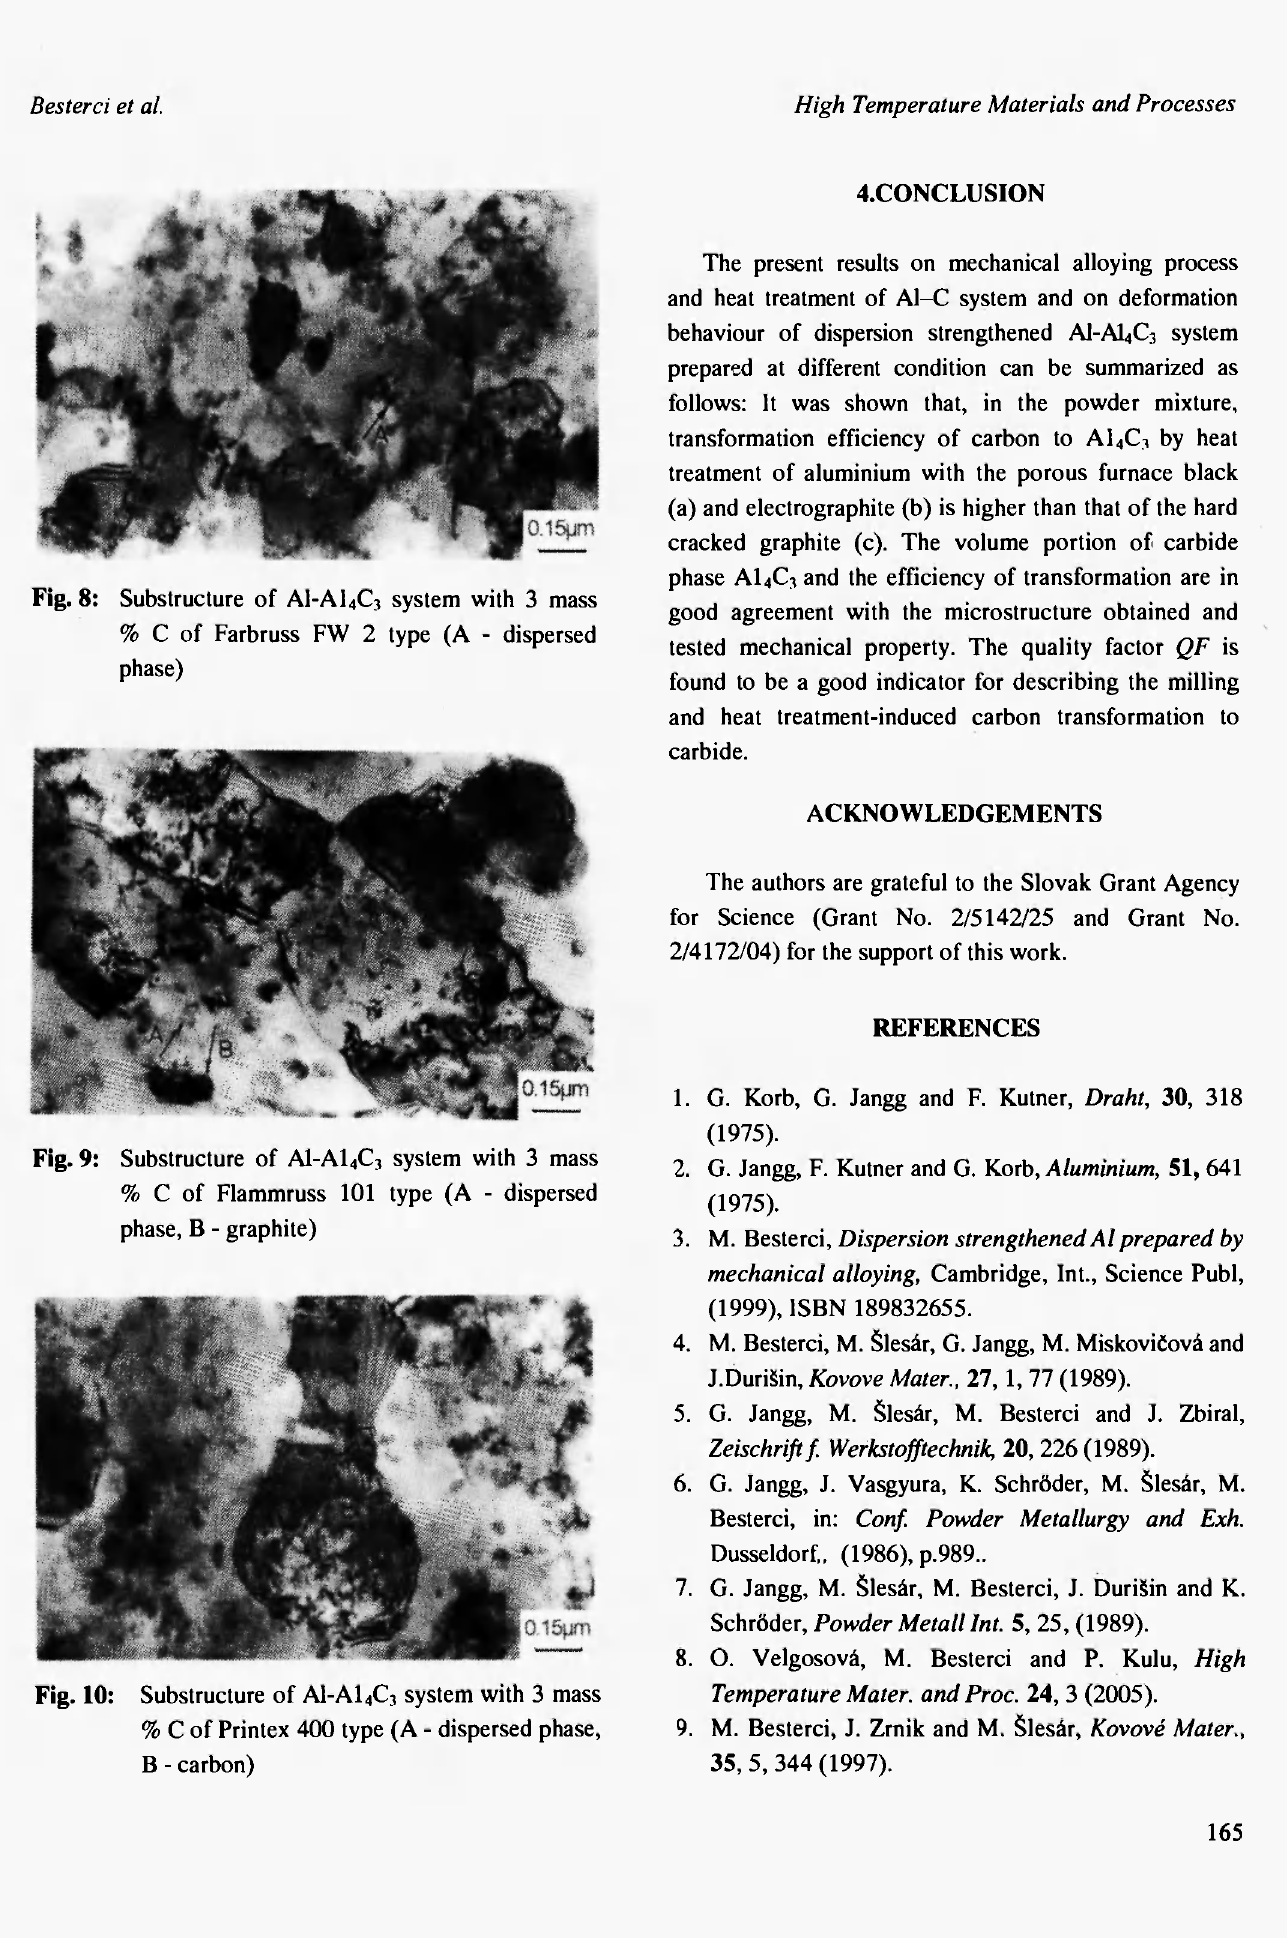
Fig. 10: Substructure of AI-AI4C3 system with 3 mass % C of Printex 400 type (A - dispersed phase, Β -